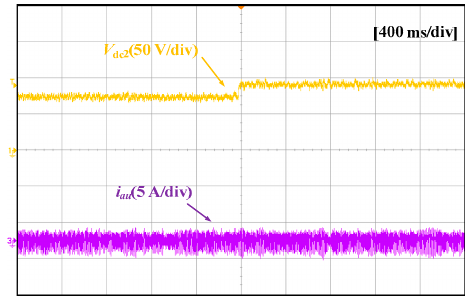
Figure 18. Output voltage and arm currents of the proposed DC-DC MMC.